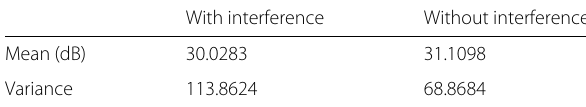
Table 2 Mean and variance of SNR With interference Without interference